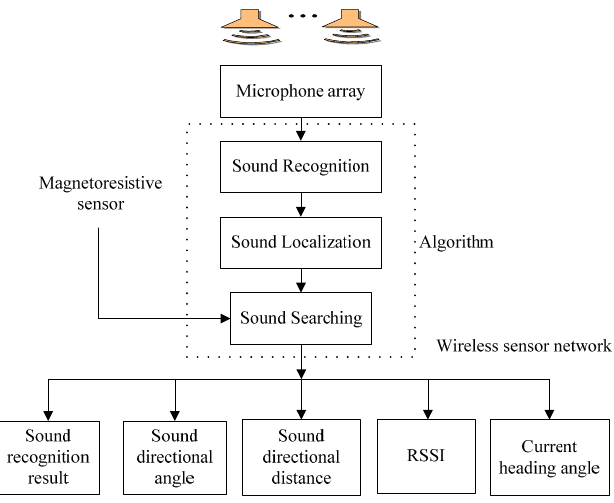
Figure 4. Functional architecture of the mobile robots in the WSN.